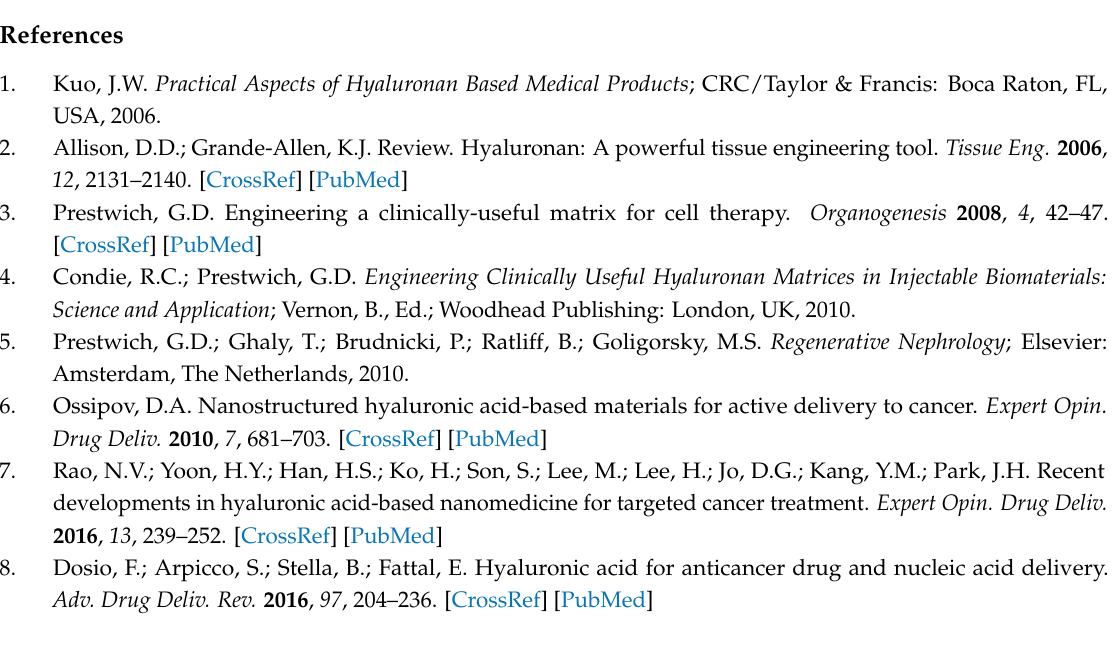
Figure S1: FT-IR ATR spectra of HA-Rfv, Figure S2: UV-Vis analysis of HA-Rfv, Figure S3: stability of empty NHs after freeze-drying, Figure S4: stability of empty NHs aqueous suspension, Figure S5: schemes of the syntheses of fluorescent HA and fluorescent NHs, Figure S6: biodistribution of HA and NHs, Figure S7: stability of NHs-piroxicam formulation, Table S1: size and PDI values of NHs-piroxicam formulation. Author Contributions: Synthesis and characterization of NHs: C.D.M., M.M. and T.C.; biological assays and analysis, I.G.-A., V.M., M.G.-A., M.M.-M., C.D.M. and M.M.-M.; writing—original draft preparation, all